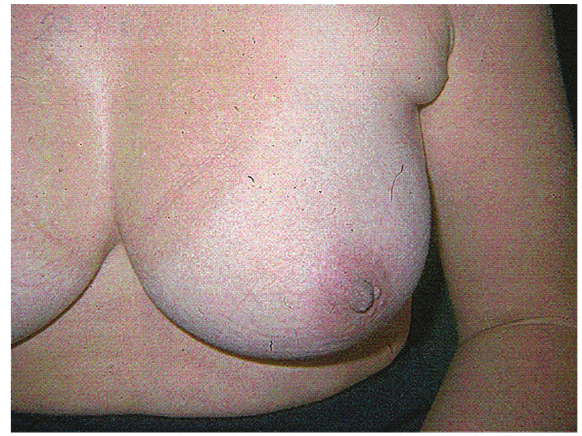
Figure 1: Ectopic axillary breast.